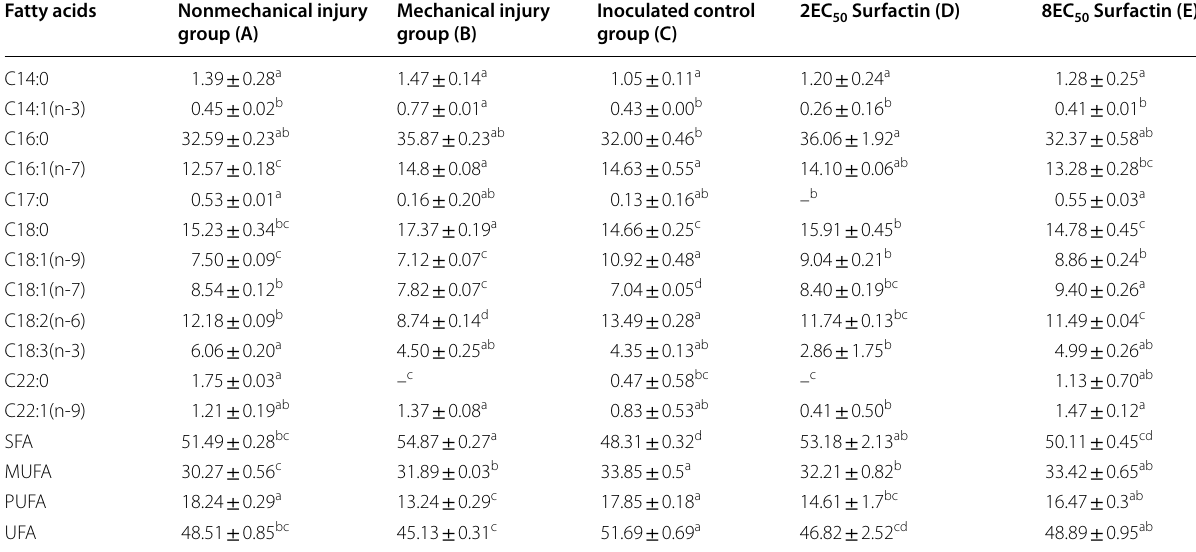
Lowercase letters show the statistical significance of the difference between groups